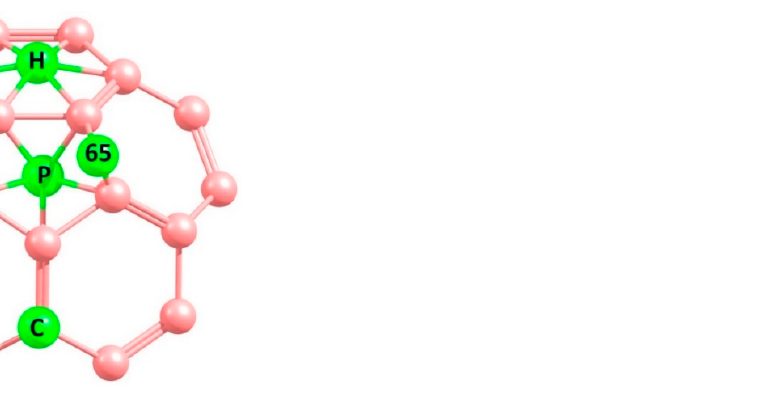
Figure 3. Five different initial sites ( H , P , 66 , 65 and C ) considered for the adsorption of a single Ti atom on the surface of C 60 . Table 2. Relative energies of five different configurations considered for the adsorption of Ti atom.